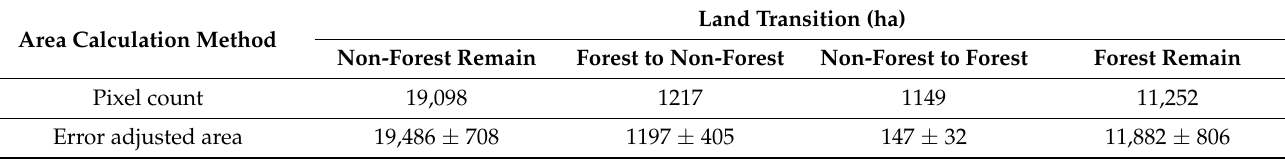
Table 3. Land transition area (hectares) for each change class using the pixel count and error-adjusted area methods. The equations detailed in Olofsson et al. [42] were used to determine the estimated error with each from–to transition with the associated 95% confidence